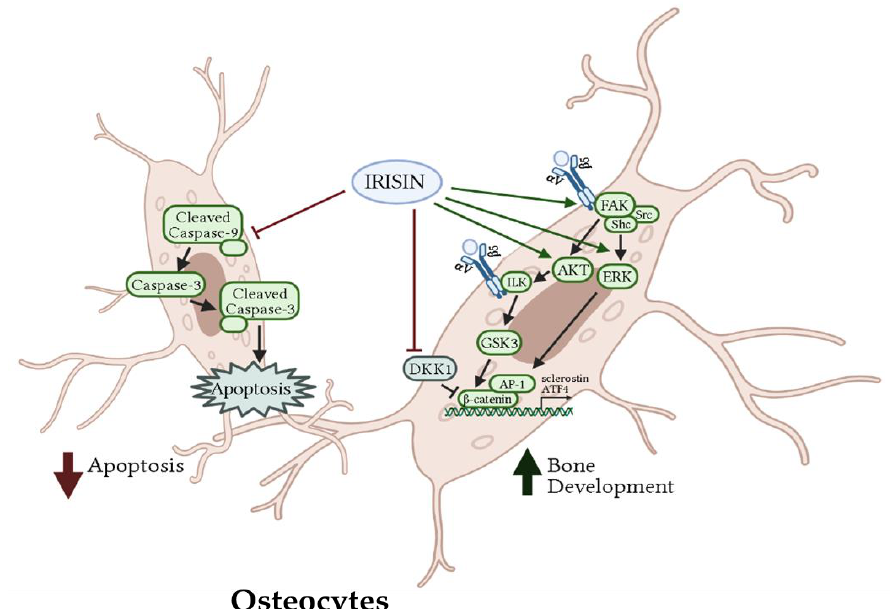
Figure 3. Effects of irisin treatment on osteocytes in vitro. The figure is based on the data of the studies [42,70,71] and created using BioRender. Available online: https://biorender.com (accessed 3 February – 17 August 2021).